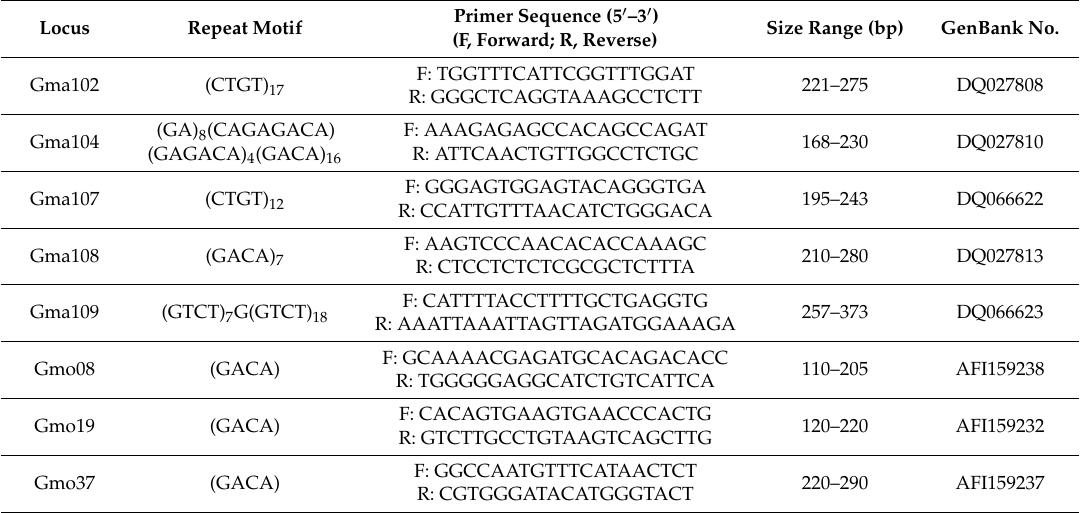
Table 7. Information for eight microsatellite loci and primers of Pacific cod in the present